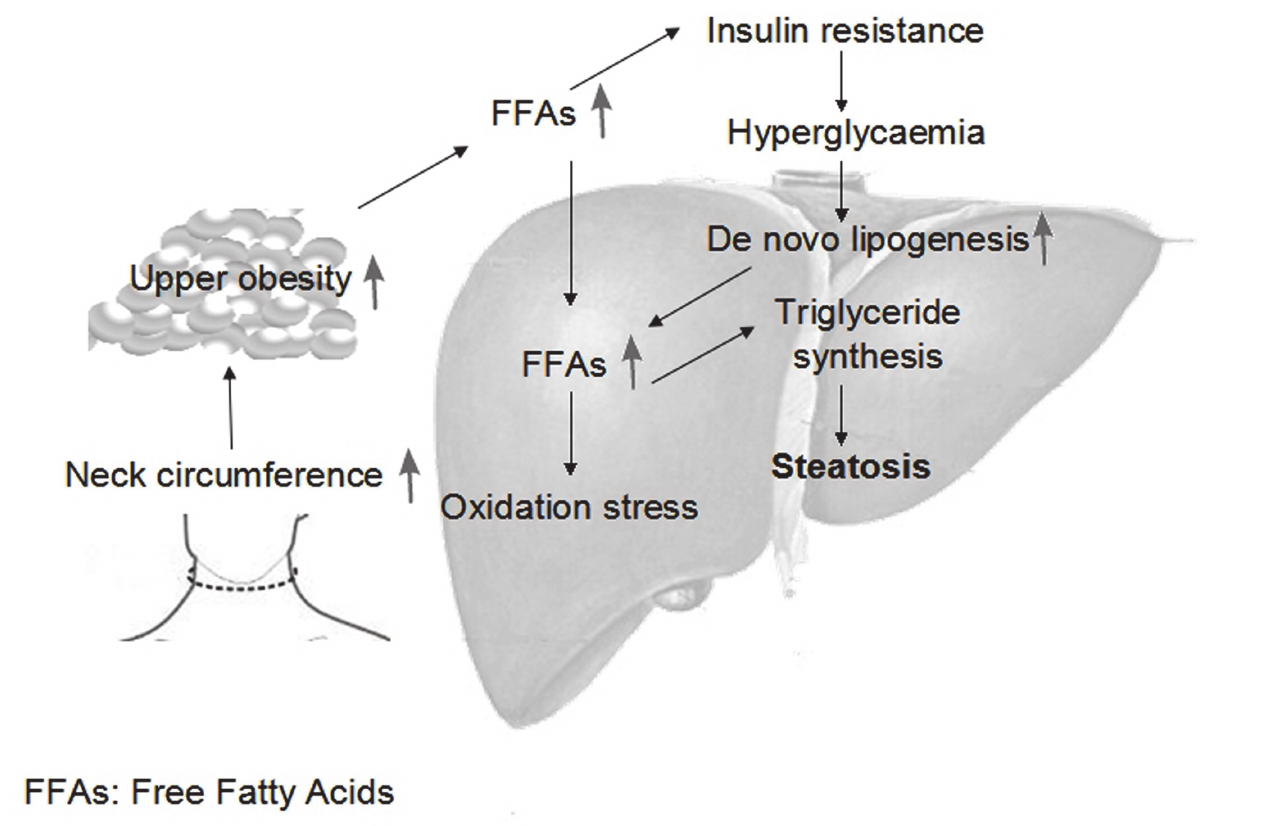
Fig 2. Mechanisms linking a hypertrophic neck with the development of fatty liver